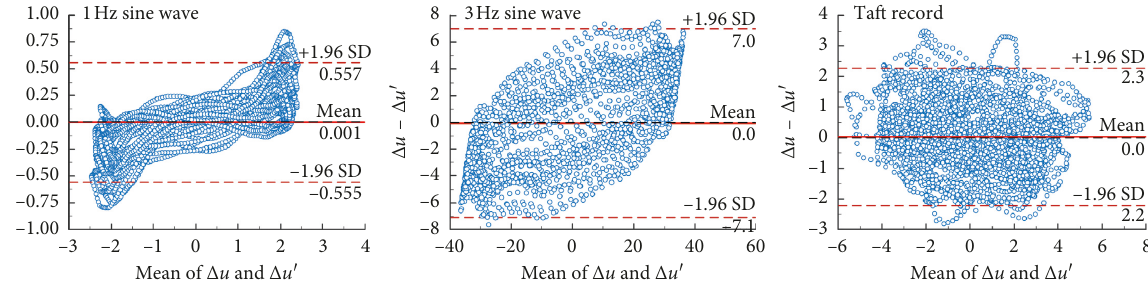
Figure 8: B-A diagram of relative displacement between experimental data and analytical solution. (a) 1Hz sine wave. (b) 3Hz sine wave. (c) Taft